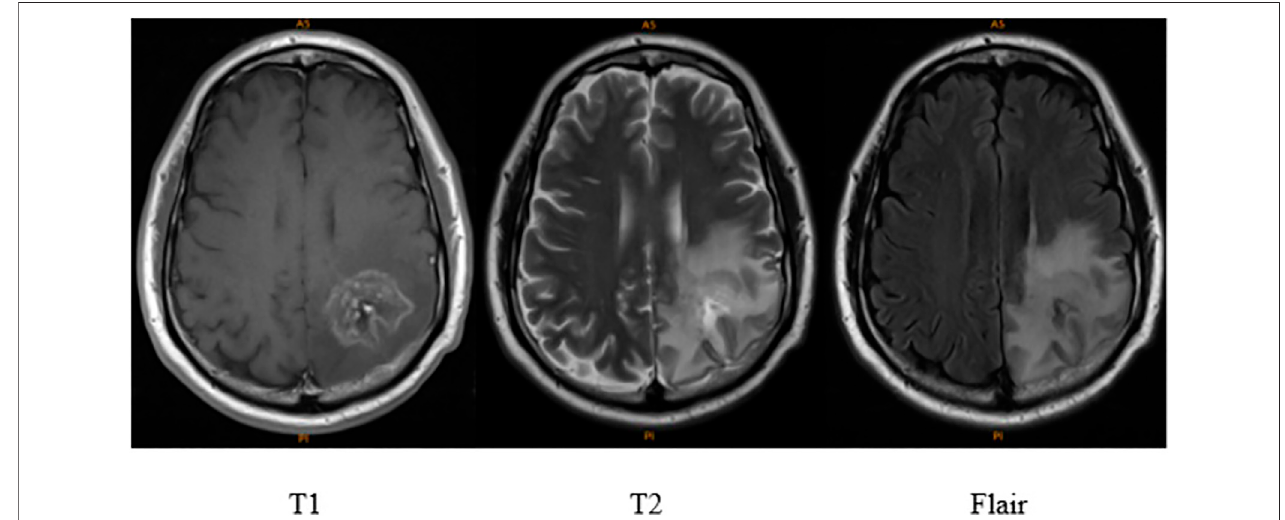
FIGURE 1 | Comparison of T1, T2 and fl air of brain tumors MRI (Clark et al., 2013; Scarpace et al., 2022).